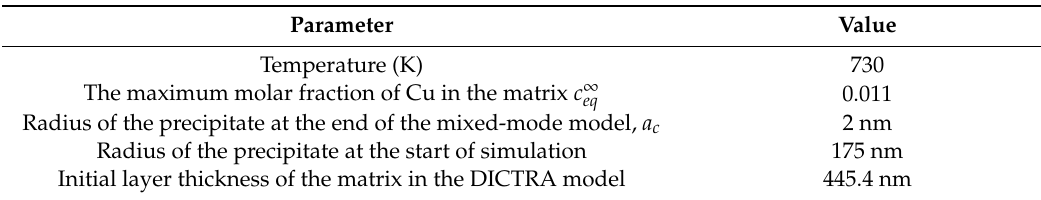
Table 3. Parameters describing the dissolution of θ -Al 2 Cu precipitates in the Al–Cu system. All other parameters are the same as in Tables 1 and